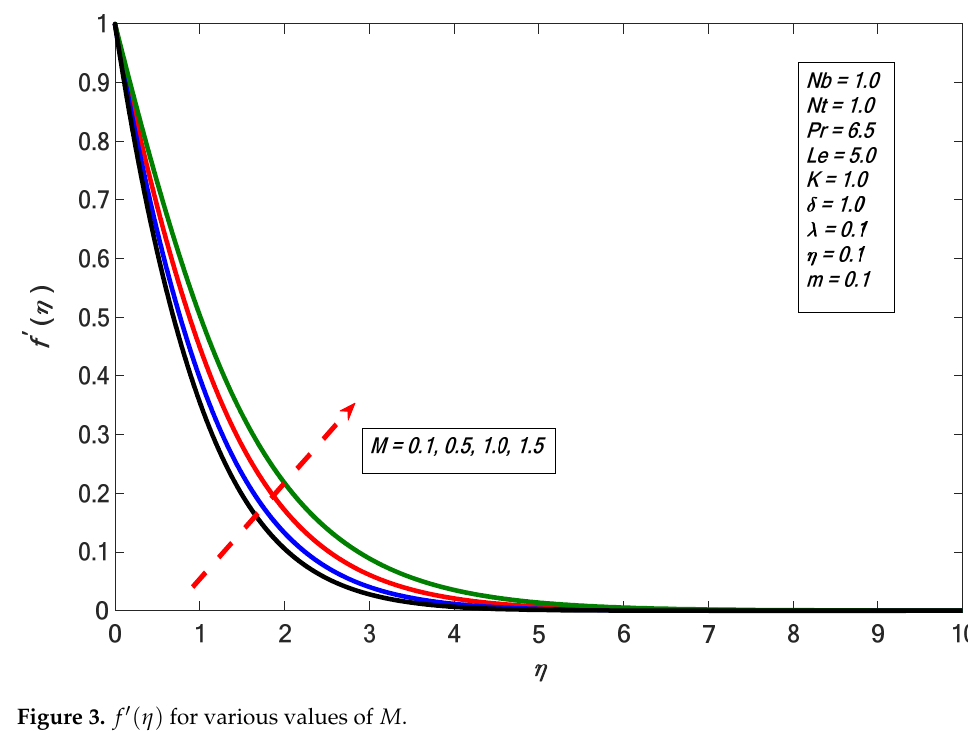
Figure 3. f (cid:48) ( η ) for various values of M . Figure 3. 𝑓′(cid:4666)𝜂(cid:4667) for various values of 𝑀.